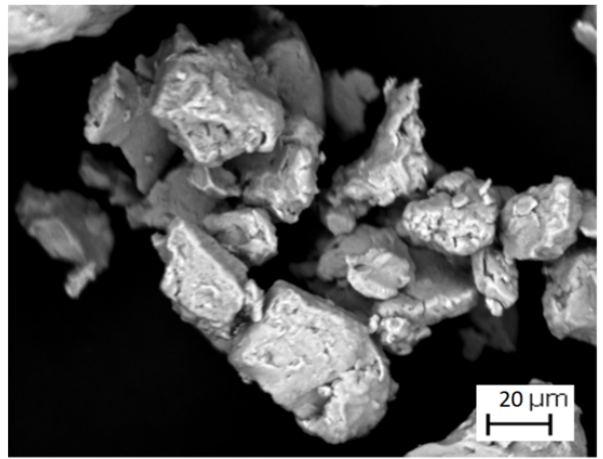
Figure 3. Morphology of the UNS S31803 steel particles with addition of 3% vanadium carbide after high energy milling for 50 h.